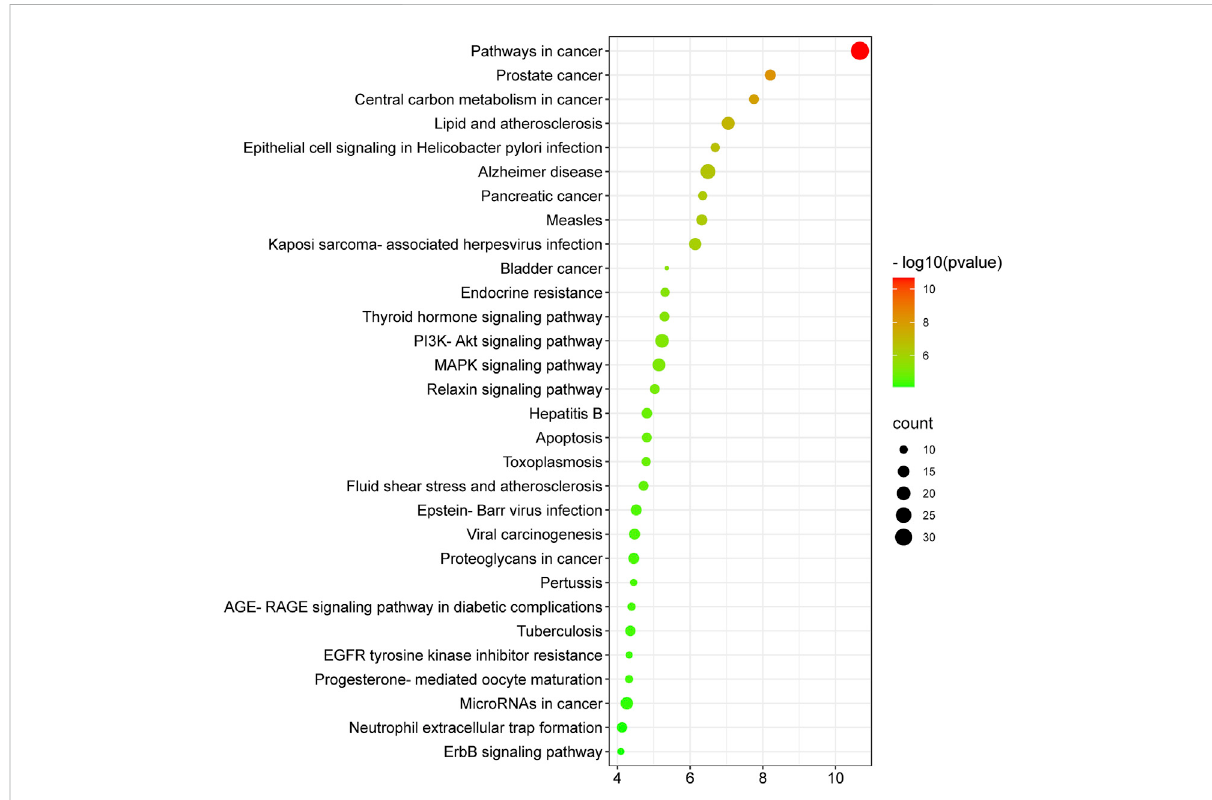
FIGURE 8 Top thirty KEGG enriched pathways of 153 intersecting targets involved in anti-HCC effects of nitazoxanide